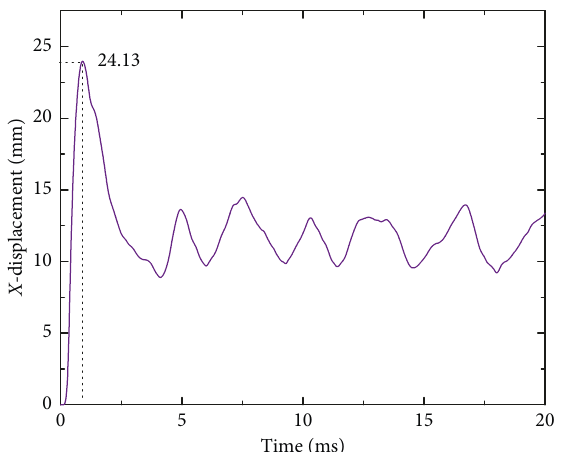
Figure 15: Displacement-time histories of the midheight point of CFSTs confined with